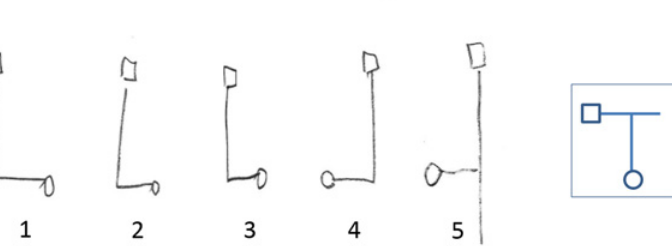
Fig 9. Sample drawings. Sample drawings from a senior participant, who completed maze B in the auditory, stationary condition. Showing trials 1 – 5 for this maze, from left to right. A circle denotes the starting point, and a square denotes the end point. Inset: a sketch of the actual maze. This example demonstrates rotation (in all 5 trials) and mirroring (in the first 3 trials, on the left) of the drawings with respect to the actual maze.